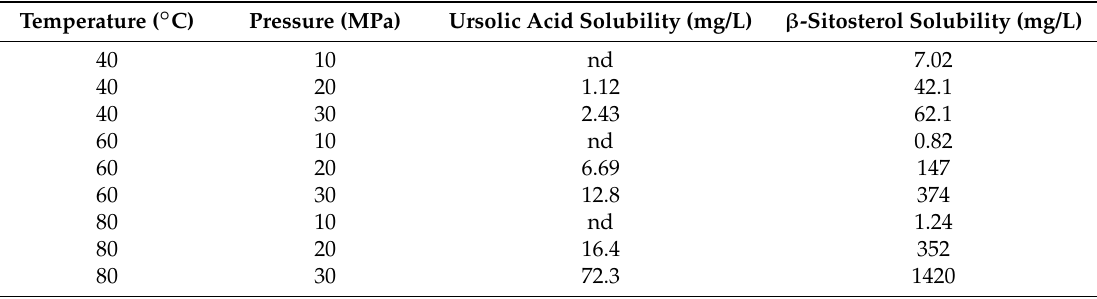
Table 1. The impact of temperature and pressure on solubility of ursolic acid and β -sitosterol in supercritical carbon